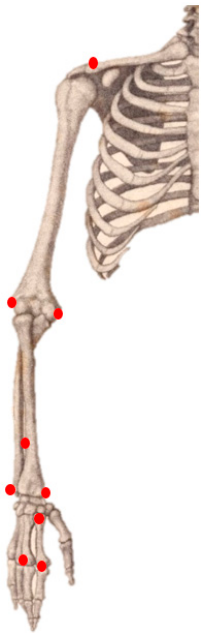
Figure 1. Placement location of the nine markers: the right upper arm (one marker on the acromion and two markers on the medial and lateral aspects of the distal humerus), forearm (two markers on the ulnar and radial styloid processes, and a third tracking marker on the distal third dorsal aspect of the forearm), and hand (proximal and distal heads of the 2nd metacarpal and distal head of the 3rd metacarpal) of each